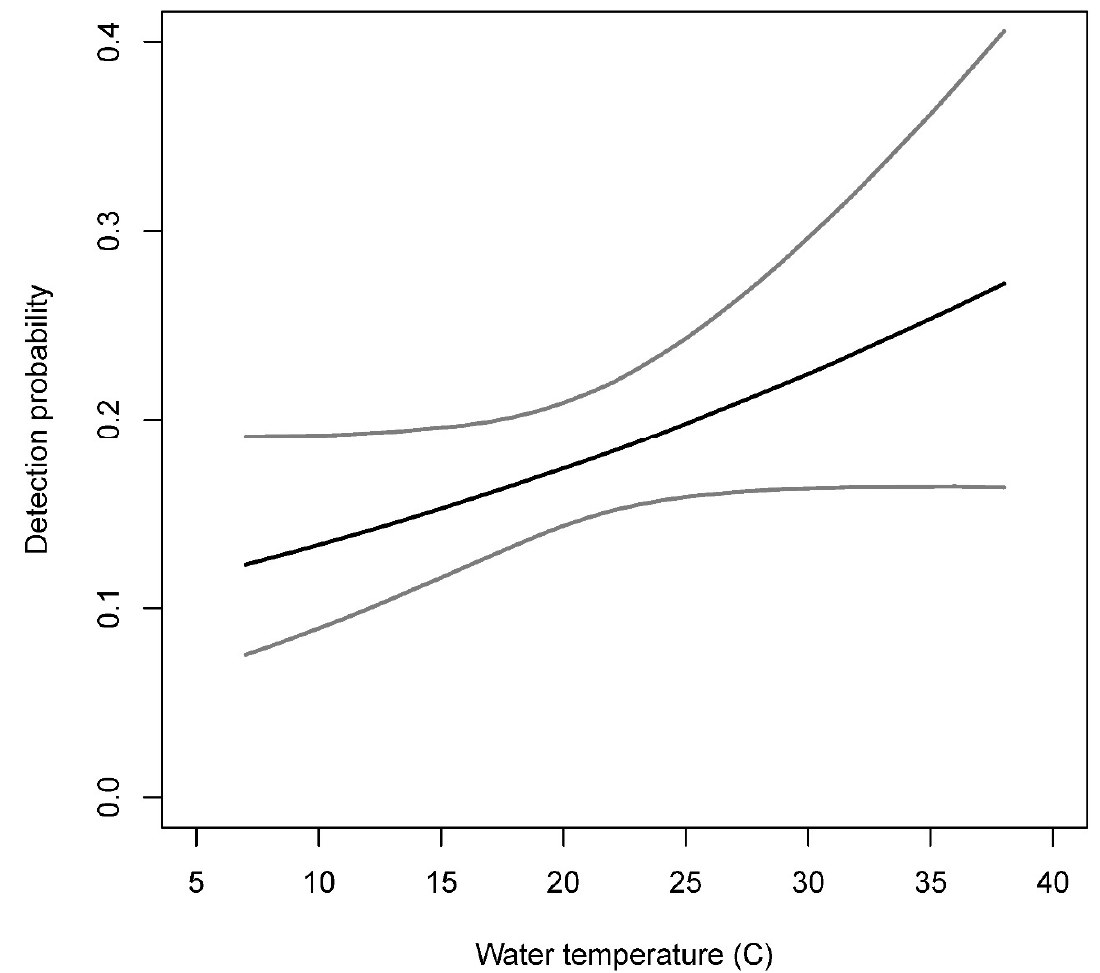
Figure 6. Backtransformed estimated detection probability (y-axis) vs. water temperature (°C) (x-axis) from fitting a dynamic occupancy model to study juvenile blue crab Callinectes sapidus demographics in eight North Carolina (USA) tidal creeks. The range of plotted water temperatures spans the range of measurements taken during replicated sampling visits to fixed sampling sites. The median estimated detection probability is shown by the black line while 97.5 and 2.5 quantile estimates are shown by the upper and lower gray lines, respectively.